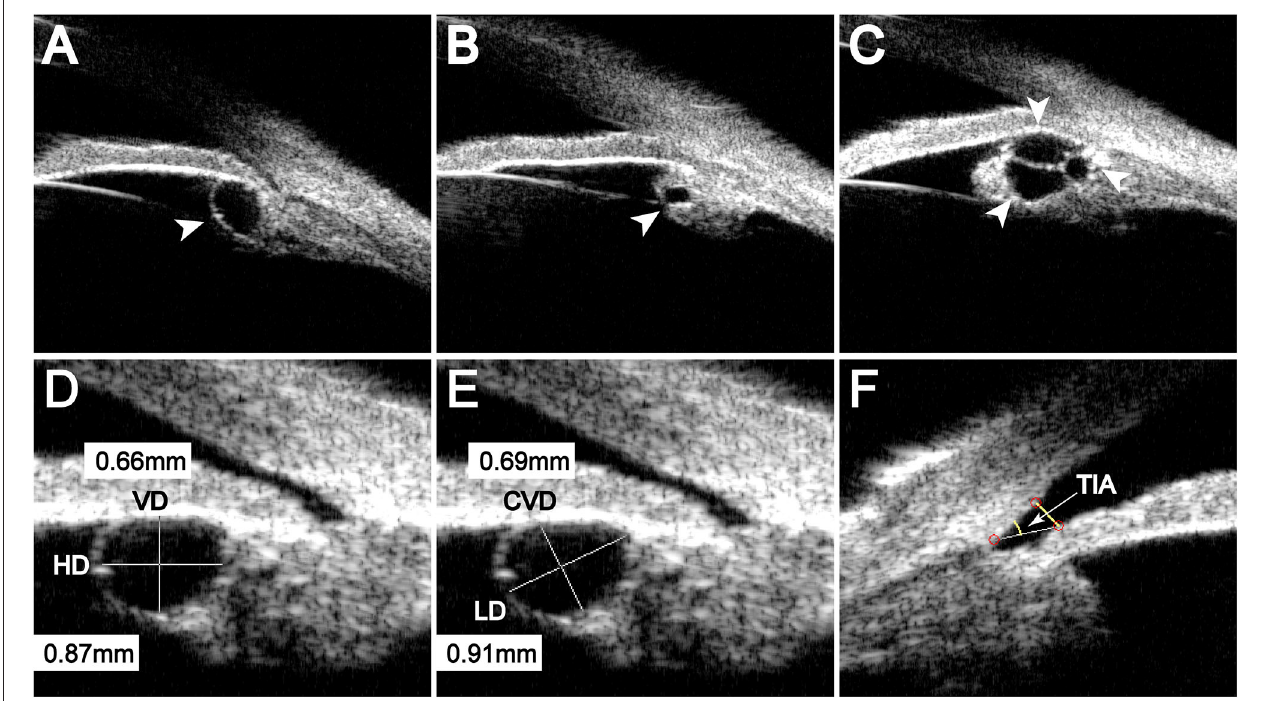
FIGURE 1 | The type and measurement of the cysts. (A) Cyst located in the iridociliary sulcus, (B) Cyst located in the ciliary body, (C) Multiple cysts. (D) and (E) Different measurement methods for the same cyst; HD, horizontal diameter; VD, vertical diameter; LD, longest diameter; CVD, corresponding vertical diameter of the LD. (F) TIA, the trabecular-iris